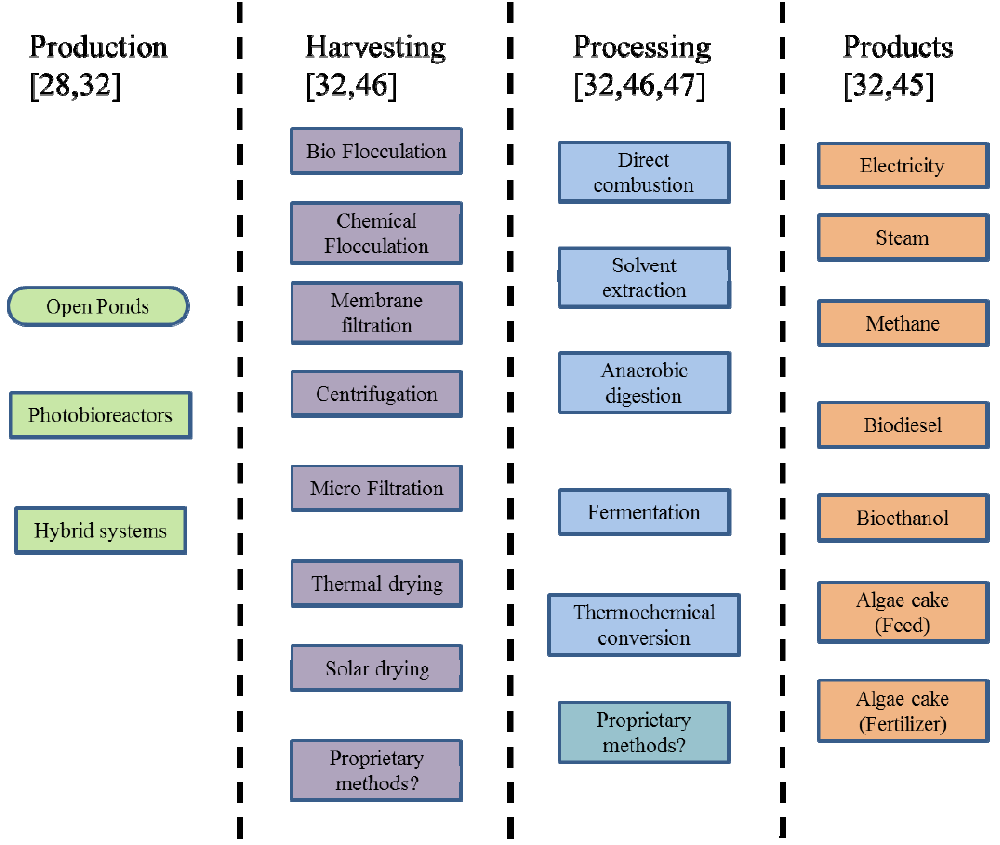
Figure 1. Production, harvesting and processing alternatives for